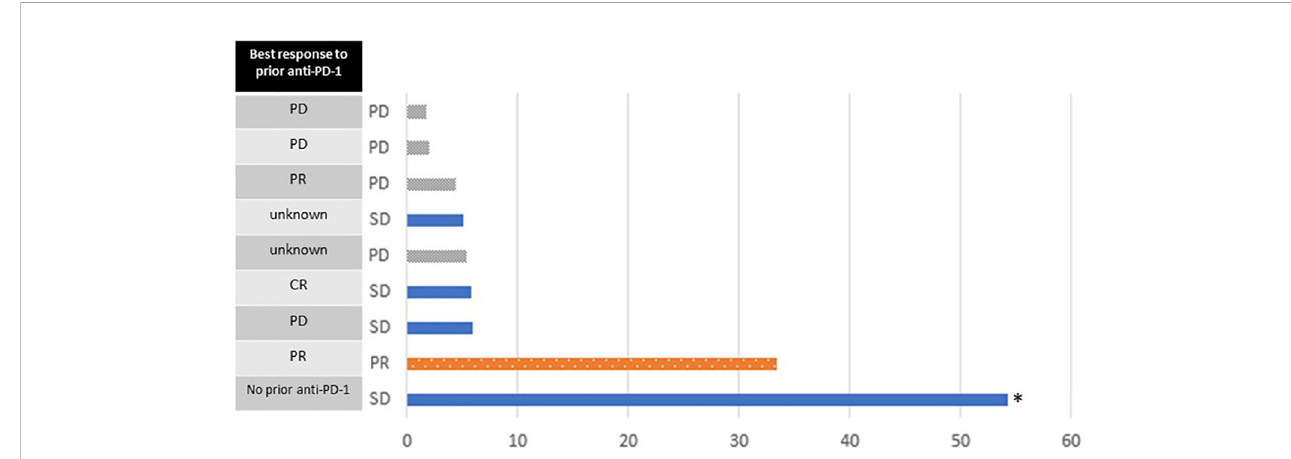
FIGURE 3 Swimmer plot of progression-free survival (months). Bars are colored according to the best response on study. Best response to prior anti-PD-1 treatment is shown on the left. The asterisk indicates data censored at the time of last